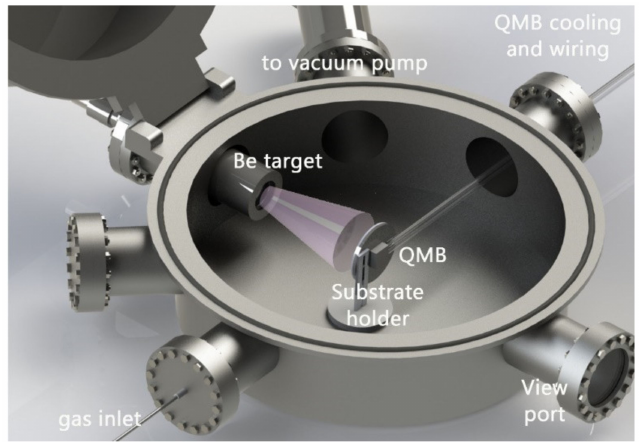
Figure 1. Schematic representation of the deposition setup. Be-D layers were deposited on three types of substrates, namely rectangular tungsten (99.95%), silicon (99.999%) and graphite (99.95%) with 12 mm × 15 mm size. The substrates were ultrasonically cleaned (GTS, Greentechno, Heras, Spain) for 15 min in a mixture of acetone and isopropyl alcohol in order to remove the debris resulted from the polishing process. Subsequently, the samples were washed abundantly using distilled water and left to dry in atmospheric air. The final step consisted in mounting the substrates onto a circular holder placed inside the vacuum chamber at a distance of 10 cm against the sputtering